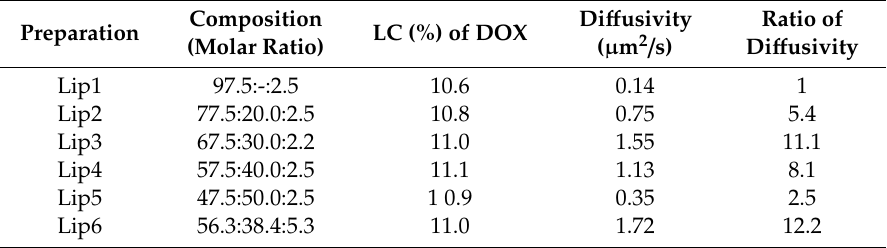
Table 1. Characterization of liposomes with di ff erent cholesterol content.